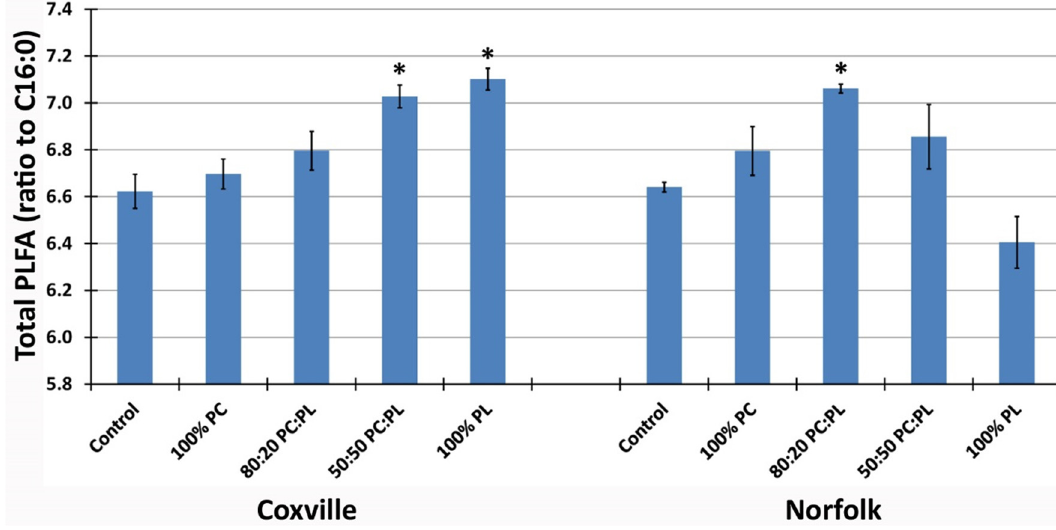
Figure 1. Total microbial biomass, presented as a ratio to C16:0 for Coxville and Norfolk soils amended with PC:PL 0:100, PC:PL 80:20, PC:PL 50:50, or PC:PL 0:100 biochar mixtures added at a 2% w:w volume. * represents statistical significance ( p < 0.01) as compared to the